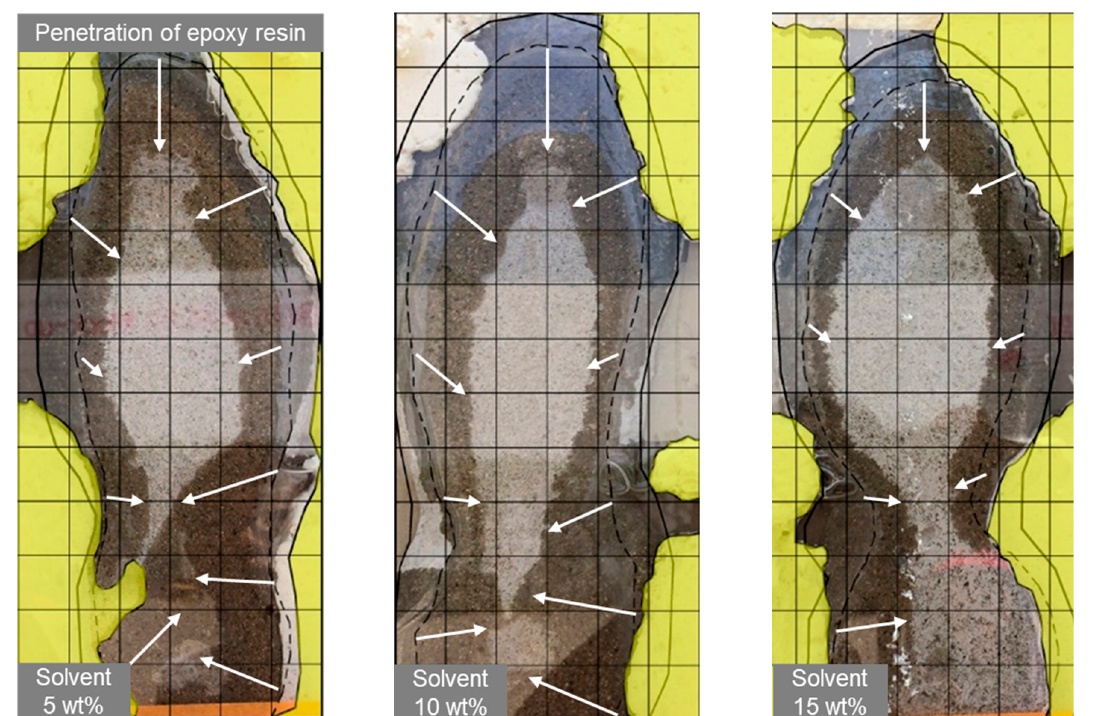
Figure 8. Permeability of epoxy resin based on the solvent mixing ratio.